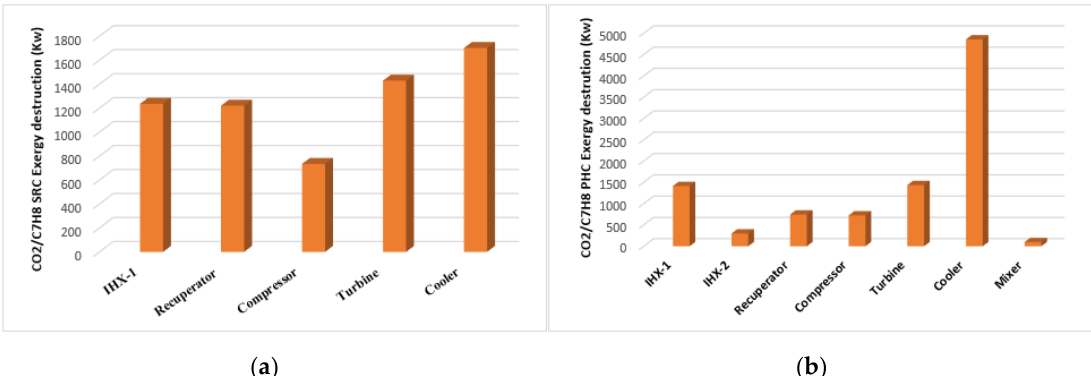
Figure 9. ( a ) Exergy destruction in components of SRC and ( b ) PHC operating with 0.9CO 2 /0.1C 7 H 8 binary mixture.